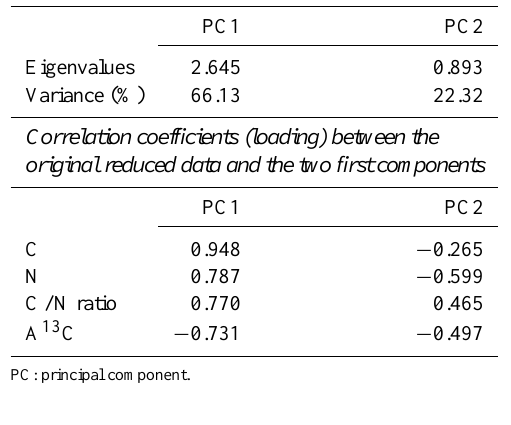
Fig. 6. Gain of 15 N mass within fractions isolated by PSDF and ADF from Ebrach and Foug`eres